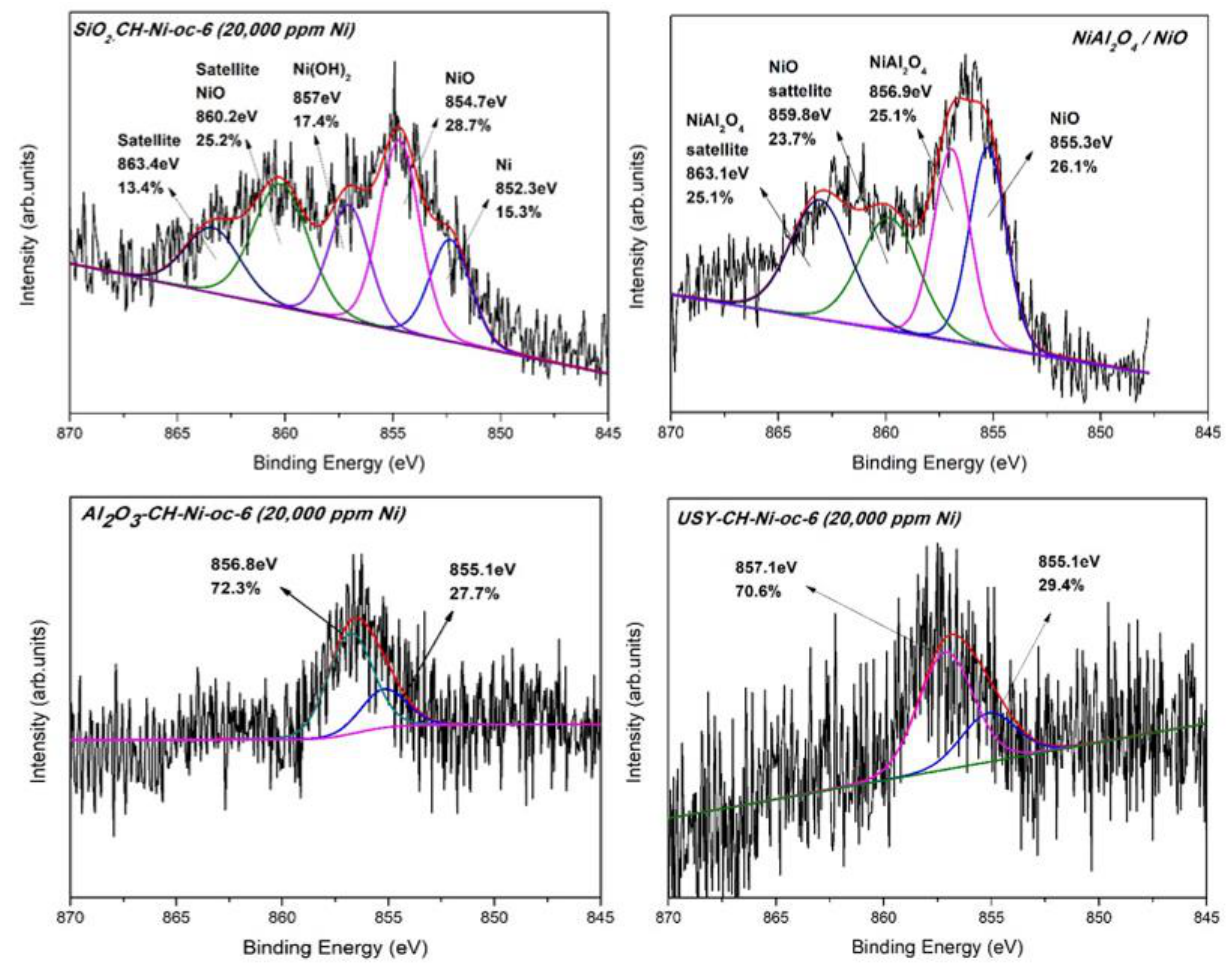
Figure 15. XPS spectra of the Ni 2p 3/2 region of representative Ni-impregnated SiO 2 , Al 2 O 3 and USY